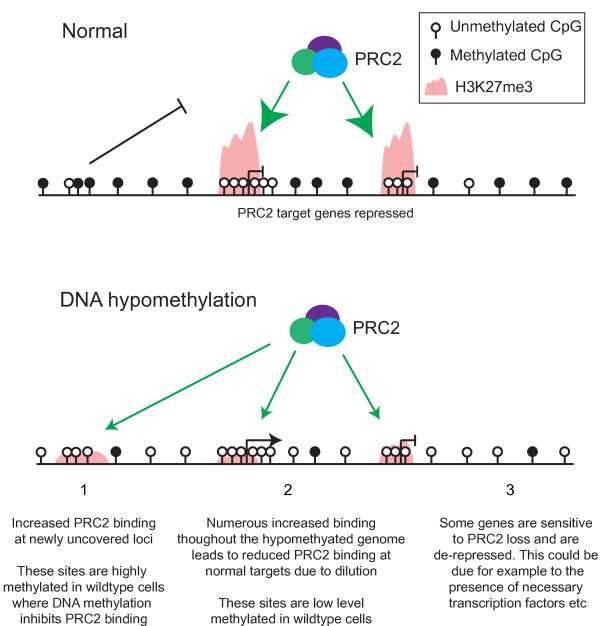
A model for de-repression of Polycomb target genes upon loss of DNA methylation. In normal cells, PRC2 is targeted to chromatin in a process that involves unmethylated stretches of DNA, such as CpG islands (PRC2 targeting is indicated by green arrows). DNA methylation has a negative effect on PRC2 binding to chromatin and so constrains PRC2 targeting. When global DNA methylation levels are reduced, PRC2 binding and H3K27me3 increase at numerous additional genomic loci leading to a dilution of available PRC2 from its normal targets. Note that only loci that are somehow permissive to PRC2 binding show increased H3K27me3 in hypomethylated cells. Reduced PRC2 binding to its normal target promoters results in loss of transcriptional repression. PRC2, Polycomb Repressive Complex 2.